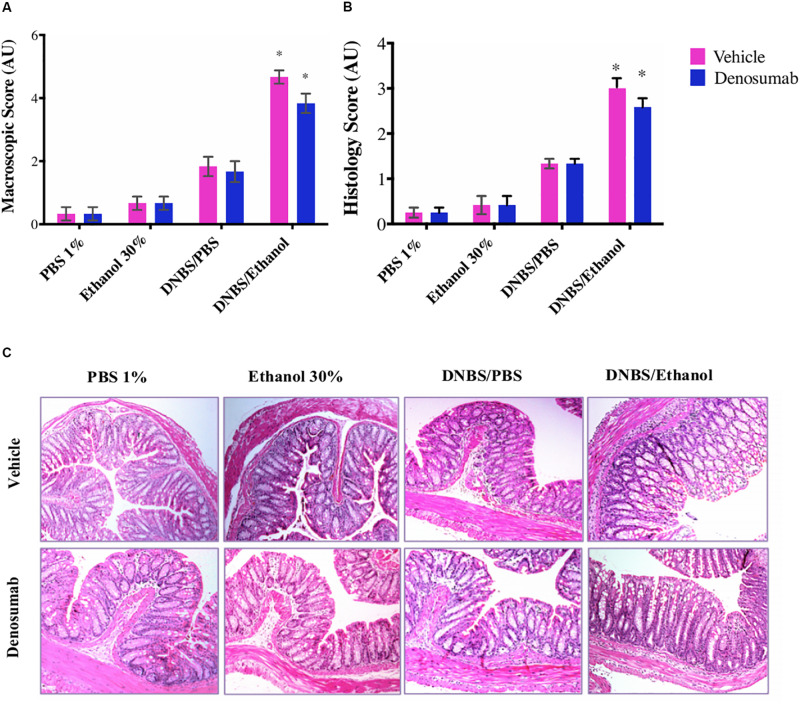
The effects of DNBS/Ethanol-induced colitis and denosumab treatment on macroscopic score and representative hematoxylin and eosin (H&E) stained colon mucosa, histologic and score. (A) Colonic macroscopic score. (B) Histological scores. (C) The H&E stained colon mucosa section showed a significant disruption of epithelial integrity, necrosis and transmural infiltration of immune cells. DNBS/Ethanol group increased (p = 0.03) the histological score while denosumab did not alleviate colitis. AU: arbitrary unit. Error bars are shown as SEM. *p < 0.001 when compared with other induction models within the denosumab or vehicle group calculated using SAS MIXED procedure and illustrated by Prism using two-way ANOVA. n = 6 mice per group.